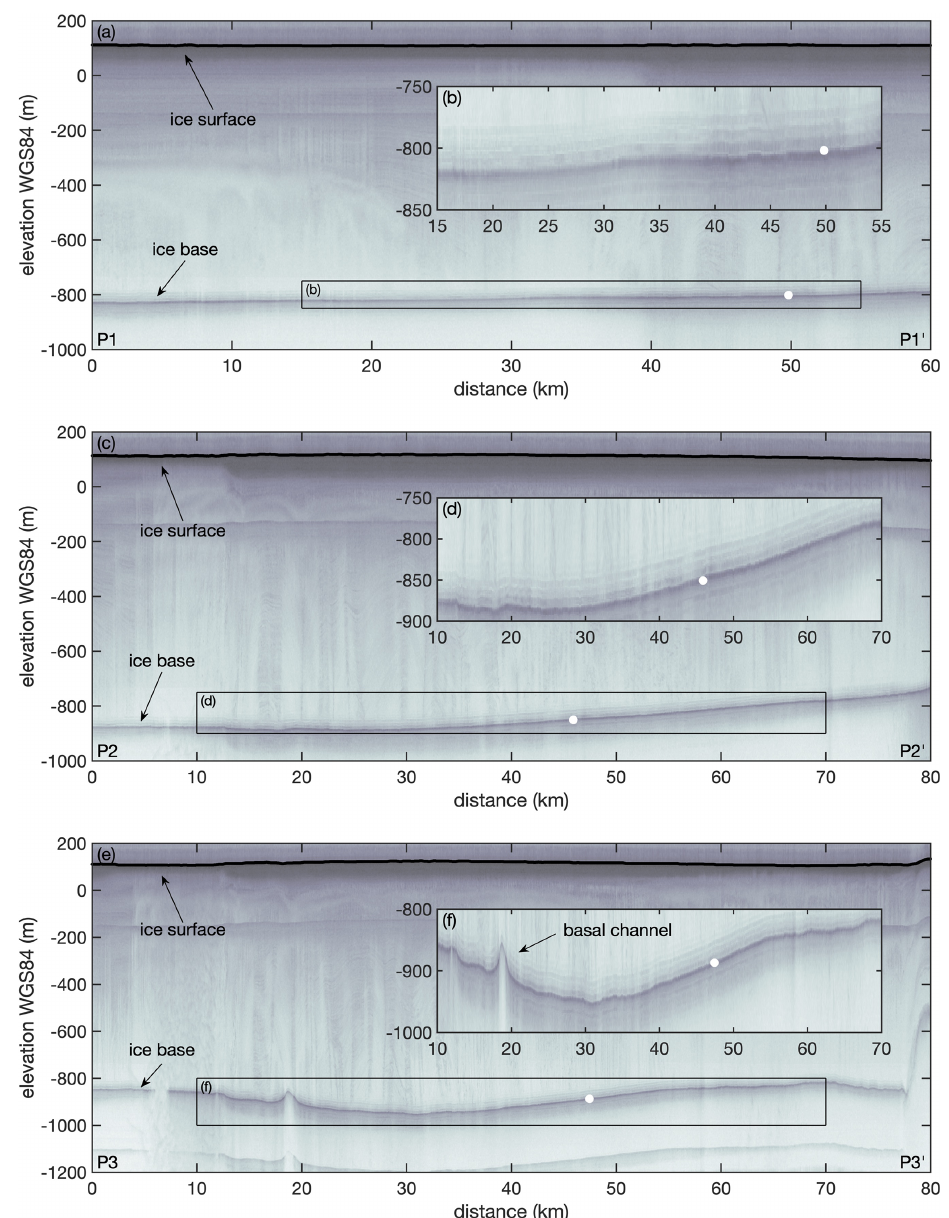
Figure A1. Airborne radar echograms (a) P1, (c) P2 and (e) P3 (location in Fig. 1), recorded with a Multi-channel Coherent Radar Depth Sounder (MCoRDS) as part of NASA’s Operation IceBridge (OIB) campaign in 2016 (Paden et al., 2014, updated 2019; Arnold et al., 2020). ( b , d and f ) Insets showing enlarged basal section visualised by black box in (a) , (c) and (e) . The white dots mark the depth of the ice base derived from a nearby pRES